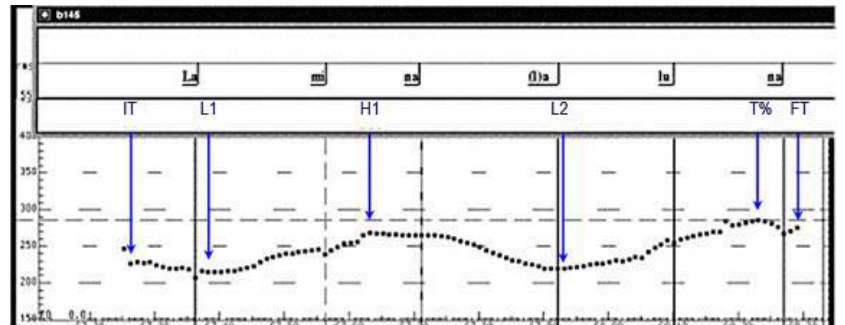
Figure 2. DS absolute interrogative sample intonational contour with landmarks illustrating the general contour pattern including for tonal comparison across declaratives and interrogatives. IT=initial tone, L1=Low tone associated with prenuclear pitch accent, H1=High tone associated with the prenuclear pitch accent, L2=the Low tone associated with the nuclear pitch accent, T%=the peak or High of the boundary tone (posttonic rise) and, FT= the final tonal value of the